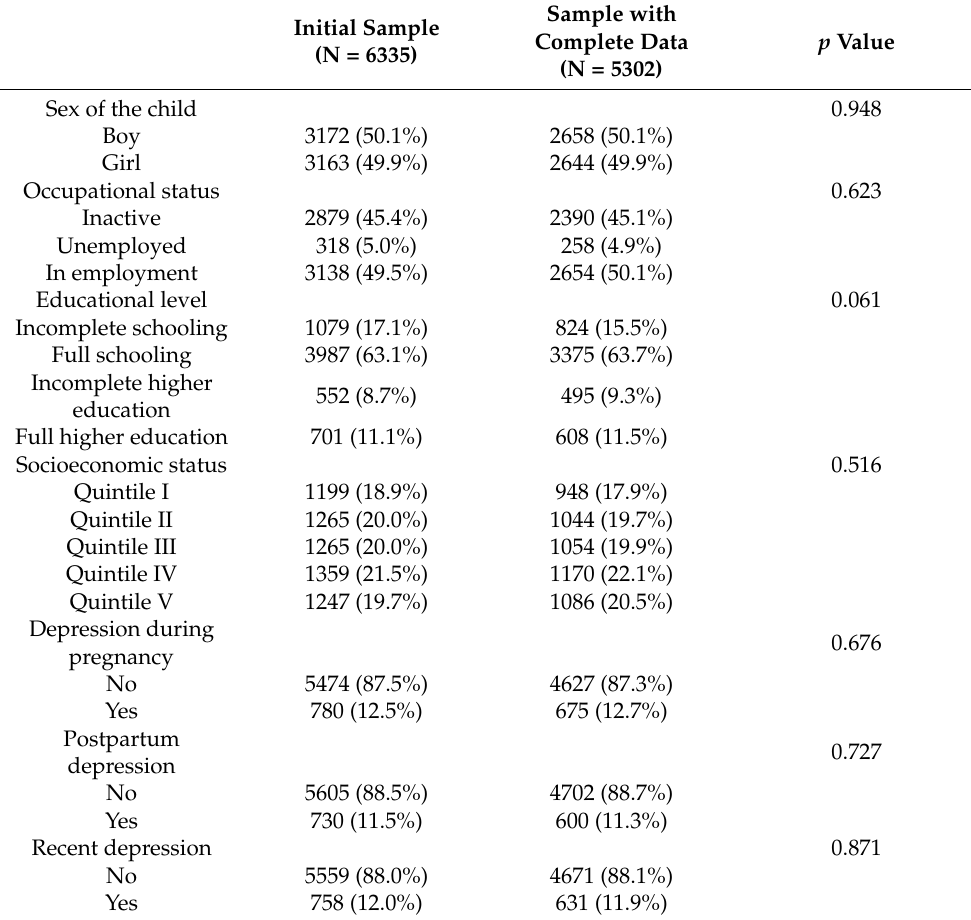
Table 3. Comparison between initial sample and sample with complete